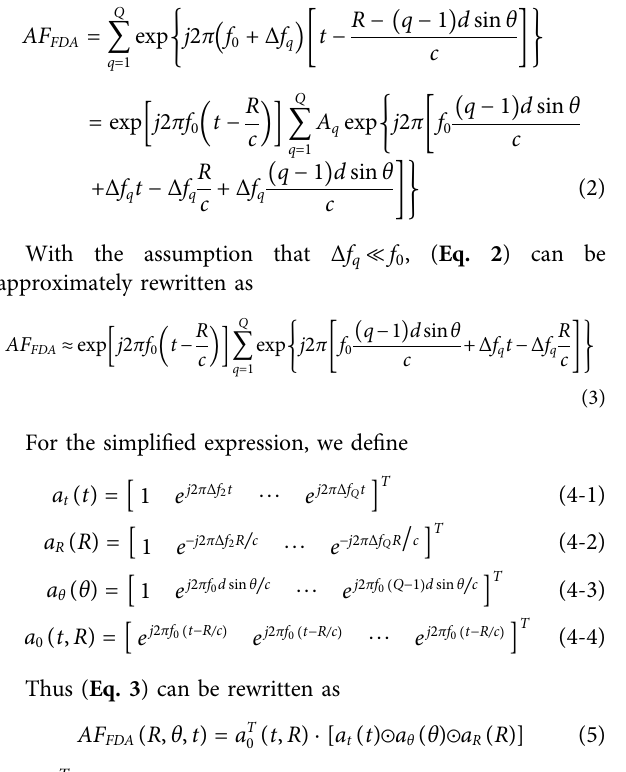
FIGURE 2 | Dual baseline phase